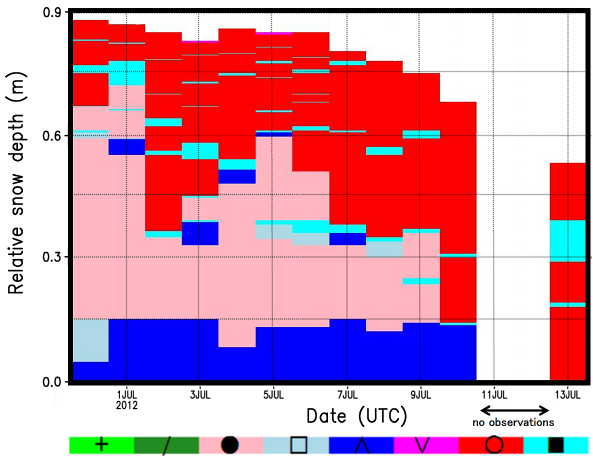
Figure 4. Temporal evolution of observed main snow grain shape profile within the NSL, which was defined by a thick bottom ice layer, at SIGMA-A during the IOP. Vertical axis (relative snow depth) denotes the height above the bottom thick ice layer. Char- acters and colors indicating snow grain shape follow the definition by Fierz et al. (2009). In sequence from the left they denote precip- itation particles, decomposing and fragmented precipitation parti- cles, rounded grains, faceted crystals, depth hoar, surface hoar, melt forms, and ice